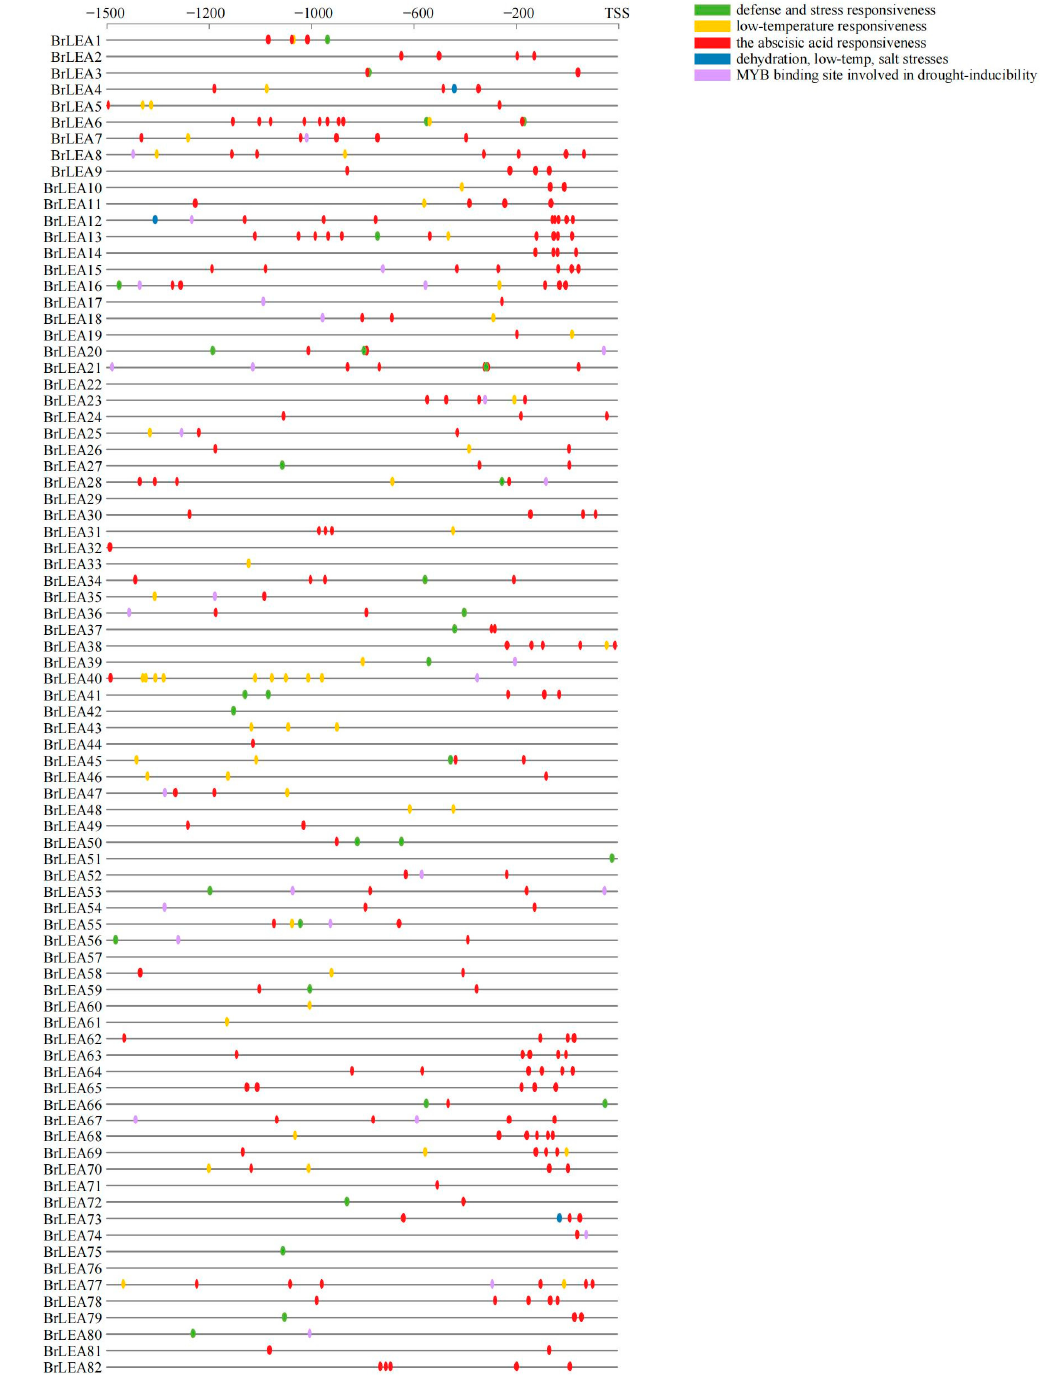
Figure 5. Analysis of cis -acting elements on the promoter region of the BrLEA gene family.